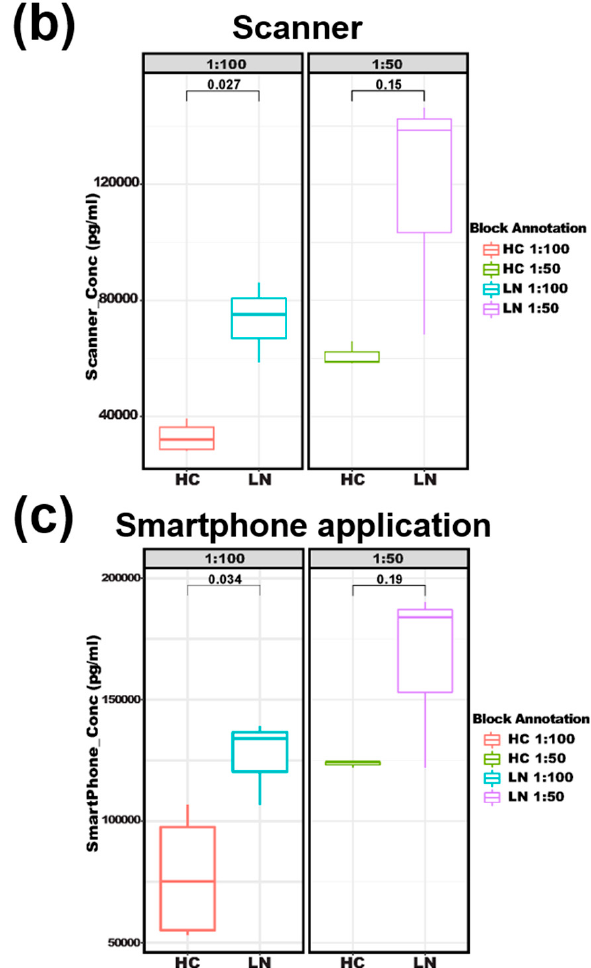
Figure 6. Testing of serum sCD14 concentrations with an antibody microarray. ( a ) Correlation of scanner reads with smartphone reads for sCD14 array results. ( b ) The scanner-based boxplot compares sCD14 levels in LN versus HC at different serum dilutions. ( c ) The smartphone-based boxplot compares sCD14 in LN versus HC at different serum dilutions. HC: healthy control, LN: lupus nephritis, Std: recombinant CD14 protein as a standard, sCD14: soluble CD14.